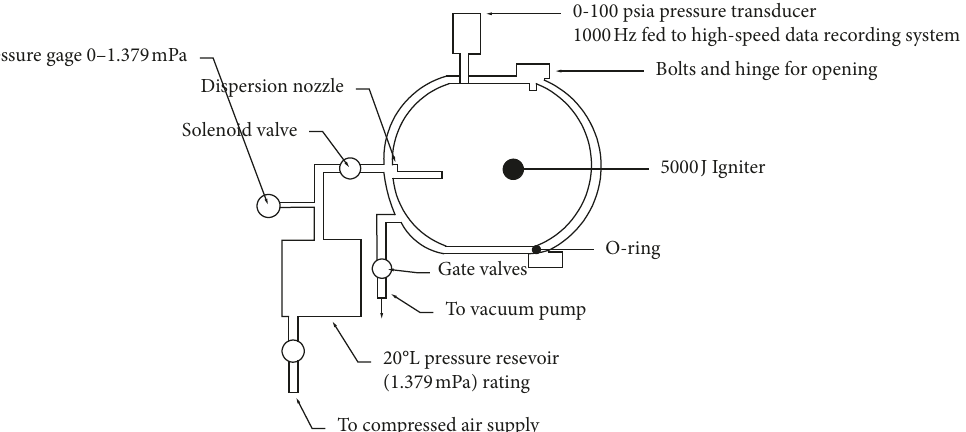
Figure 2: Schematic of the 38 L explosive chamber [9].